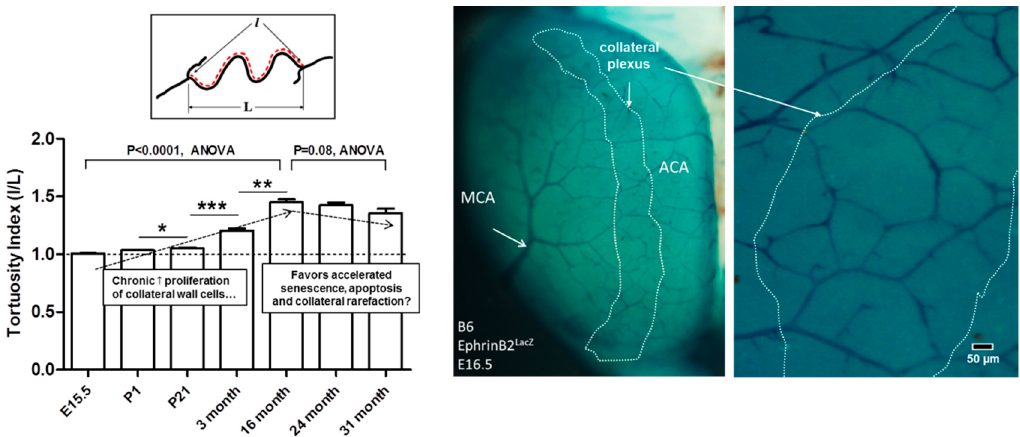
Figure 8. Tortuosity increases progressively with time after formation of collaterals. Images at right, ephrin-B2 LacZ reporter mouse (construction of mutant described in [6]) showing embryonic collaterals. Bar graph, tortuosity index = l / L (axial length of collateral ÷ scalar length connecting collateral endpoints). E, embryonic day, P, post-natal day. Data for last four bars from Faber et al. [17] who also showed that collateral diameter and number begin to decline at or after 16 months of age. Number of mice (C57BL / 6, B6) for bars 1–7: 8,9,8,9,10,7,8. For each mouse tortuosity, was determined for all MCA–ACA collaterals and averaged. ANOVA followed by 1-sided Bonferroni t-tests, *, **, ***, p < 0.05, 0.01, 0.001, respectively.